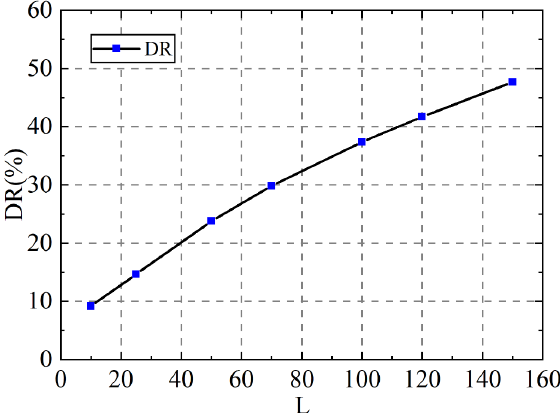
Figure 8. Drag reduction rate of different maximum extensibility of the polymer molecule ( L ) .